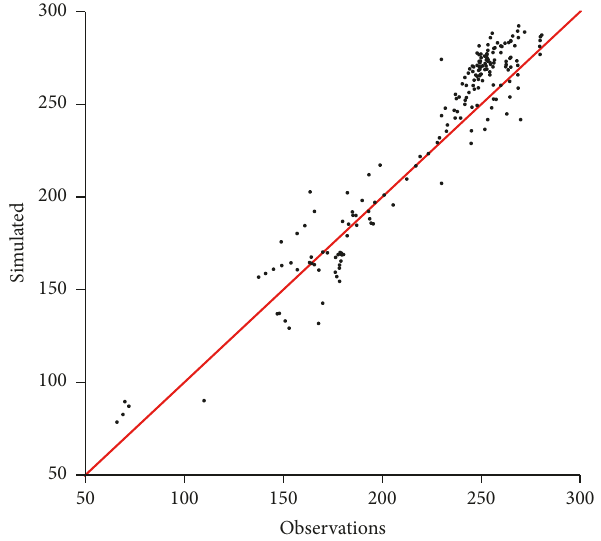
Figure 7: Groundwater model calibration diagram. Black points represent each water level datum observed and its simulated posi- tion. Red line is 𝑋 = 𝑌